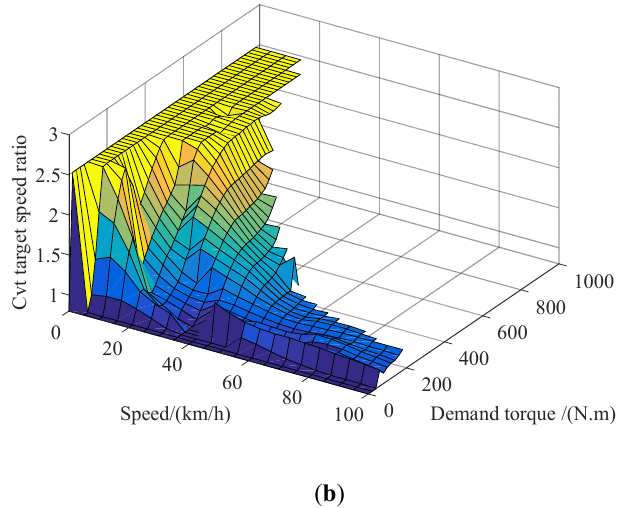
Figure 14. Optimization results in the regenerative braking mode: ( a ) target torque of motor; ( b ) target speed ratio of CVT.